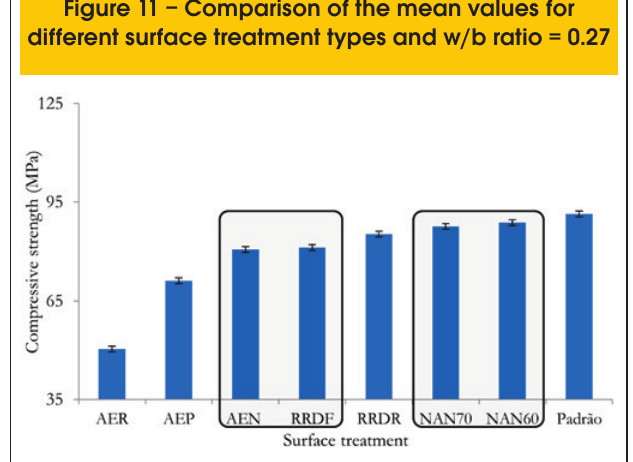
Figure 12 – Comparison of the mean values for different surface treatment types and w/b ratio = 0.20